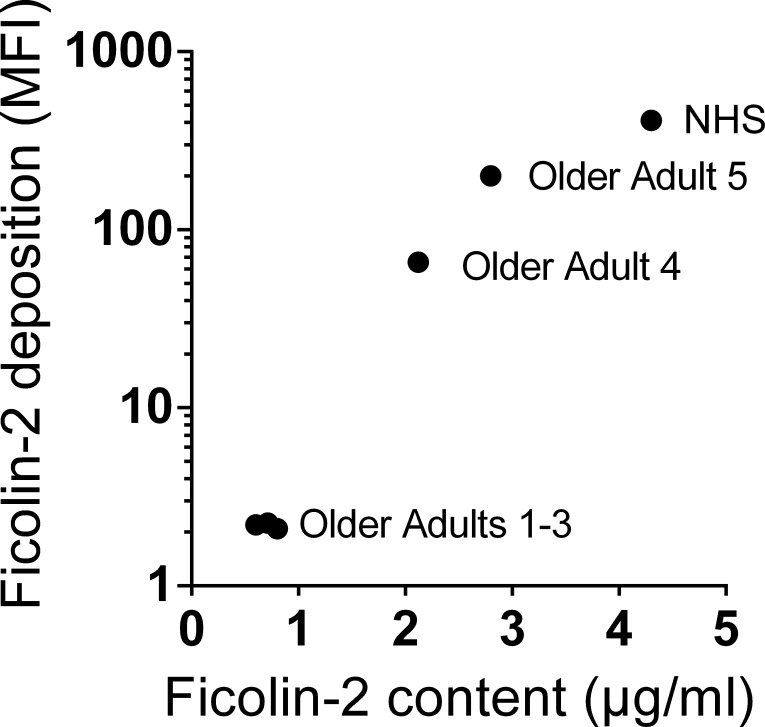
Some older individuals’ sera deposit disproportionately little ficolin-2 on serotype 11A bacteria.Sera were evaluated for ficolin-2 deposition on serotype 11A pneumococcus by flow cytometry and for ficolin-2 content by ELISA. NHS, normal human serum collected from a healthy young adult volunteer.